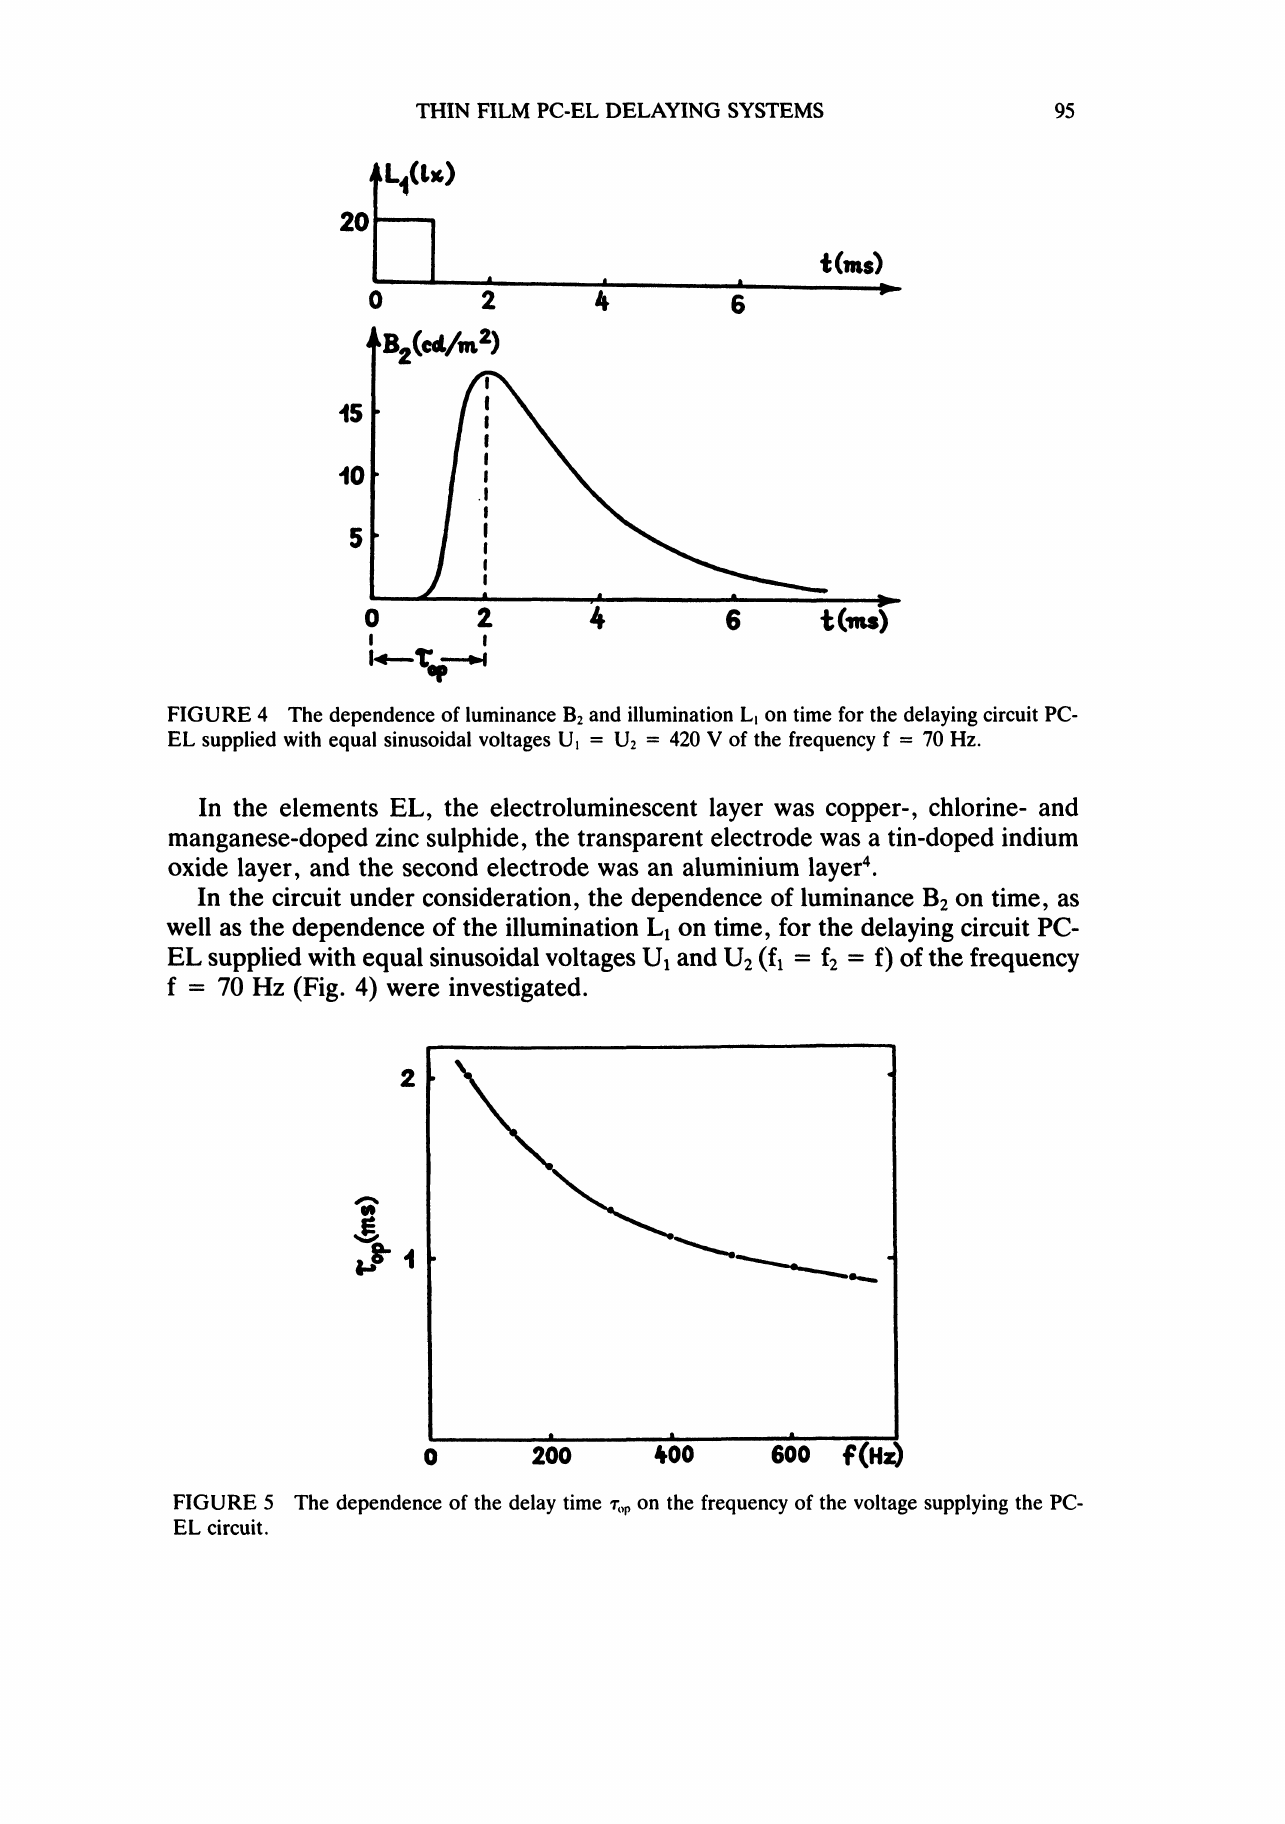
o FIGURE 5 The dependence of the delay time ’op on the frequency of the voltage supplying the PC- EL